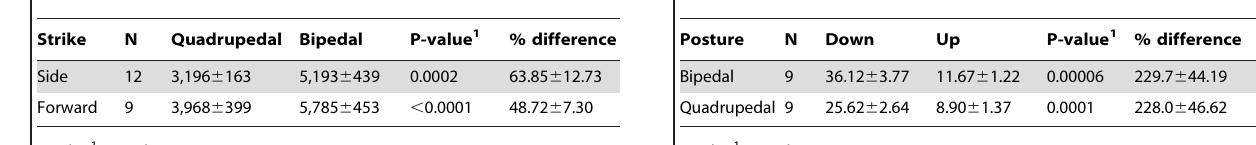
Table 2. Mean values and standard errors of maximum force (N) delivered during side and forward strikes from ‘‘quadrupedal’’ and bipedal posture.